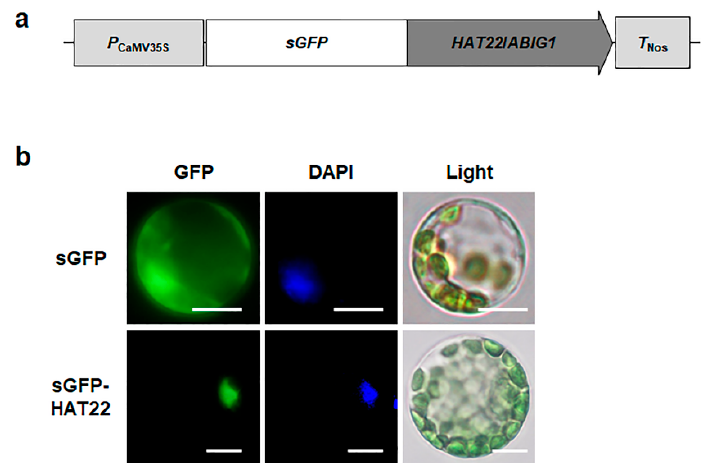
Figure 6. Subcellular localization of HAT22/ABIG1. ( a ) A schematic map of sGFP-fused HAT22 / ABIG1 vector. ( b ) Transient expression of sGFP-HAT22/ABIG1 fusion protein in Arabidopsis protoplasts. Left, GFP signal; middle, 4 ′ ,6-diamidino-2-phenylindole (DAPI) staining; right, light microscopy images. Scale bars indicate 10 μ m.